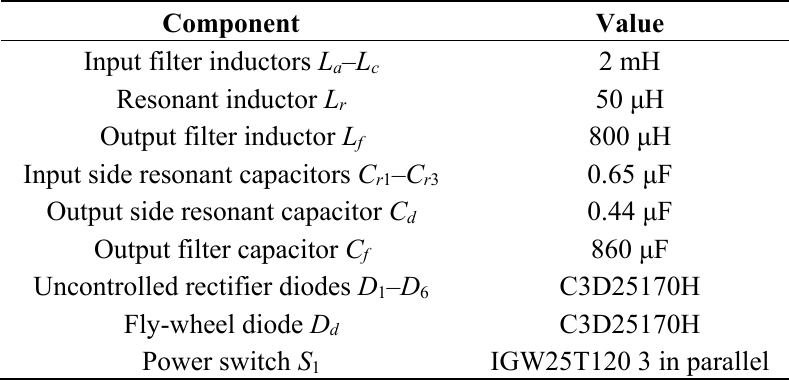
Table 2. Main components of the